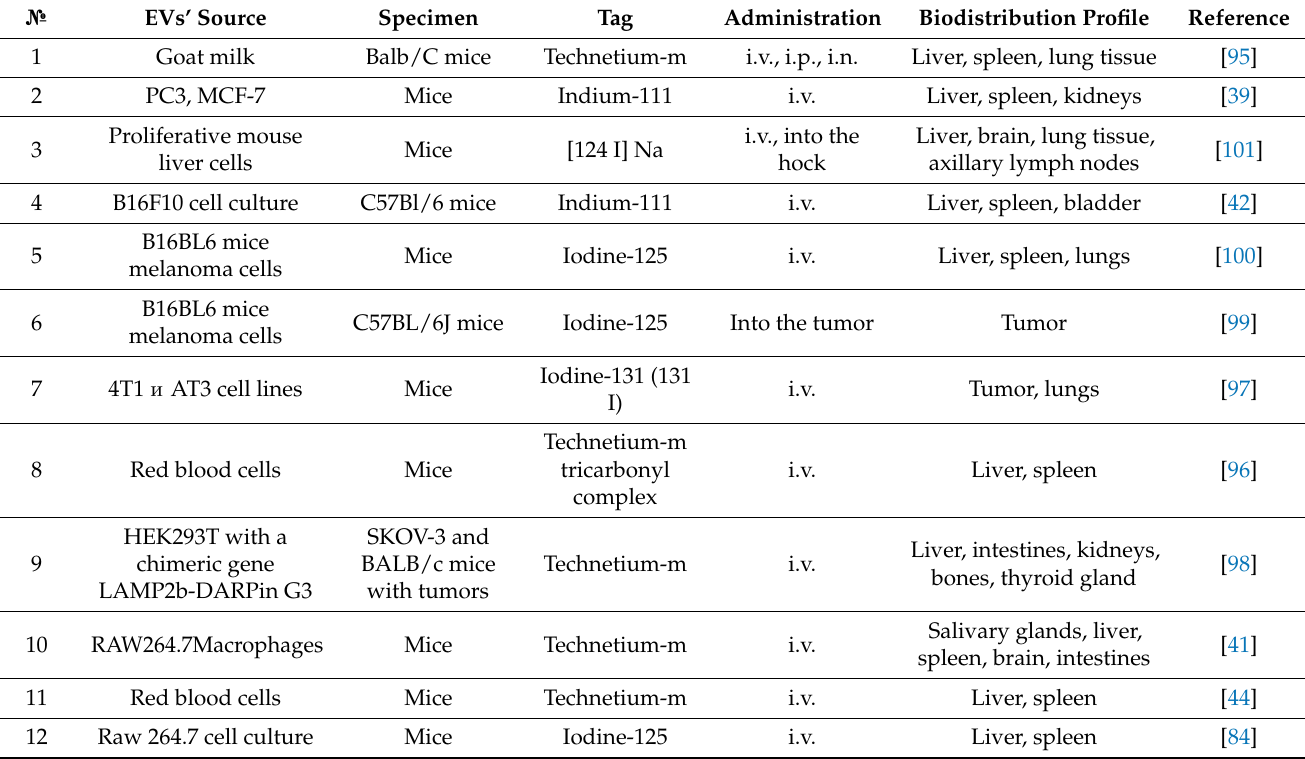
Table 3. Most commonly used nuclear imaging indicators and/or isotopes in EVs’ biodistribu- tion